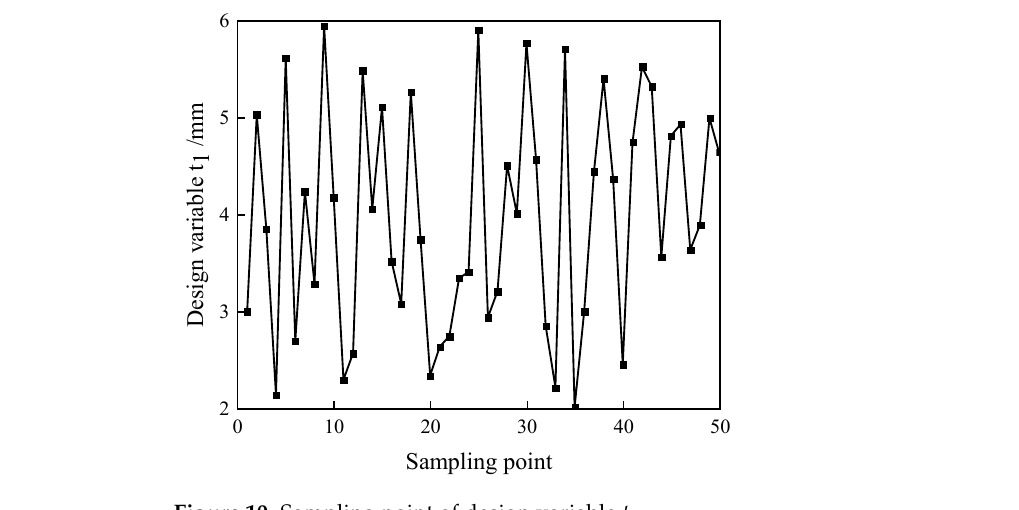
Figure 10. Sampling point of design variable t 1 . Table 2. The response of each design.